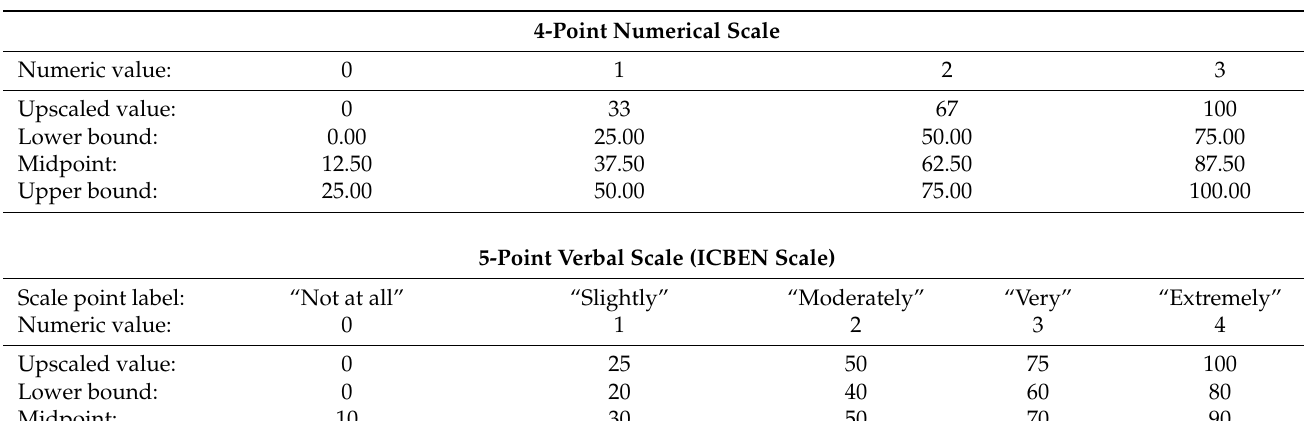
Table 2. Conversions of scale point values on 4-, 5-, 6-, 7- and 11-point scales to values on an absolute annoyance intensity scale ranging from 0 to 100, rounded to two